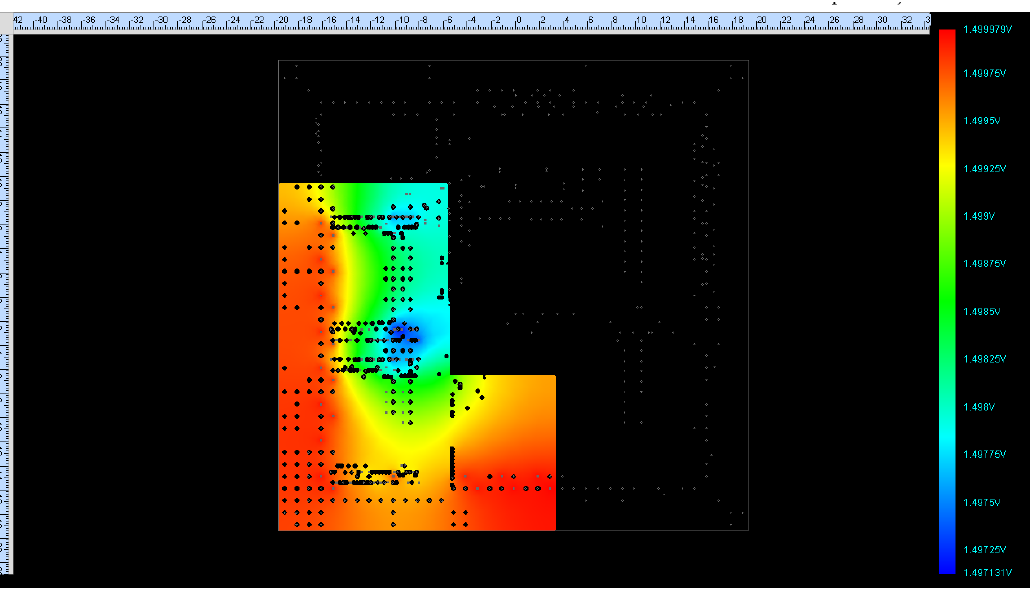
Figure 3. Voltage simulation result of the power supply DDR3 1.5 V is 1.49999~1.49737 V.